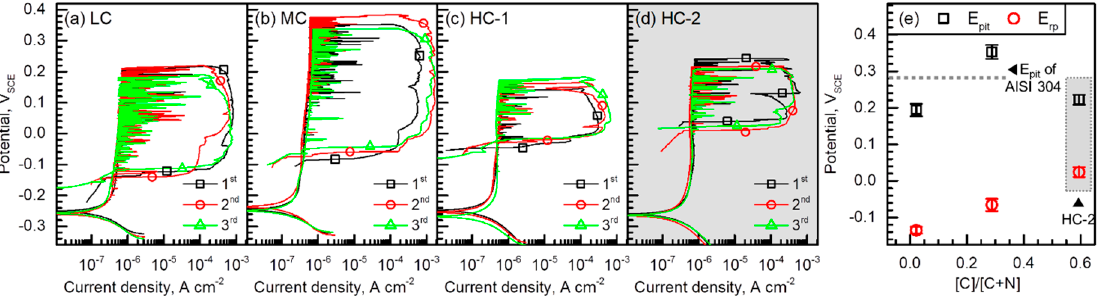
Figure 8. Cyclic potentiodynamic polarization curves of the ( a ) LC, ( b ) MC, ( c ) HC-1, and ( d ) HC-2 samples measured in a 3.5 wt% NaCl solution at 25 °C with a potential sweep rate of 0.167 mV s − 1 . ( e ) Average pitting potential ( E pit ) and repassivation potential ( E rp ) values of the samples, which were obtained from 8–10 repeated polarization tests.